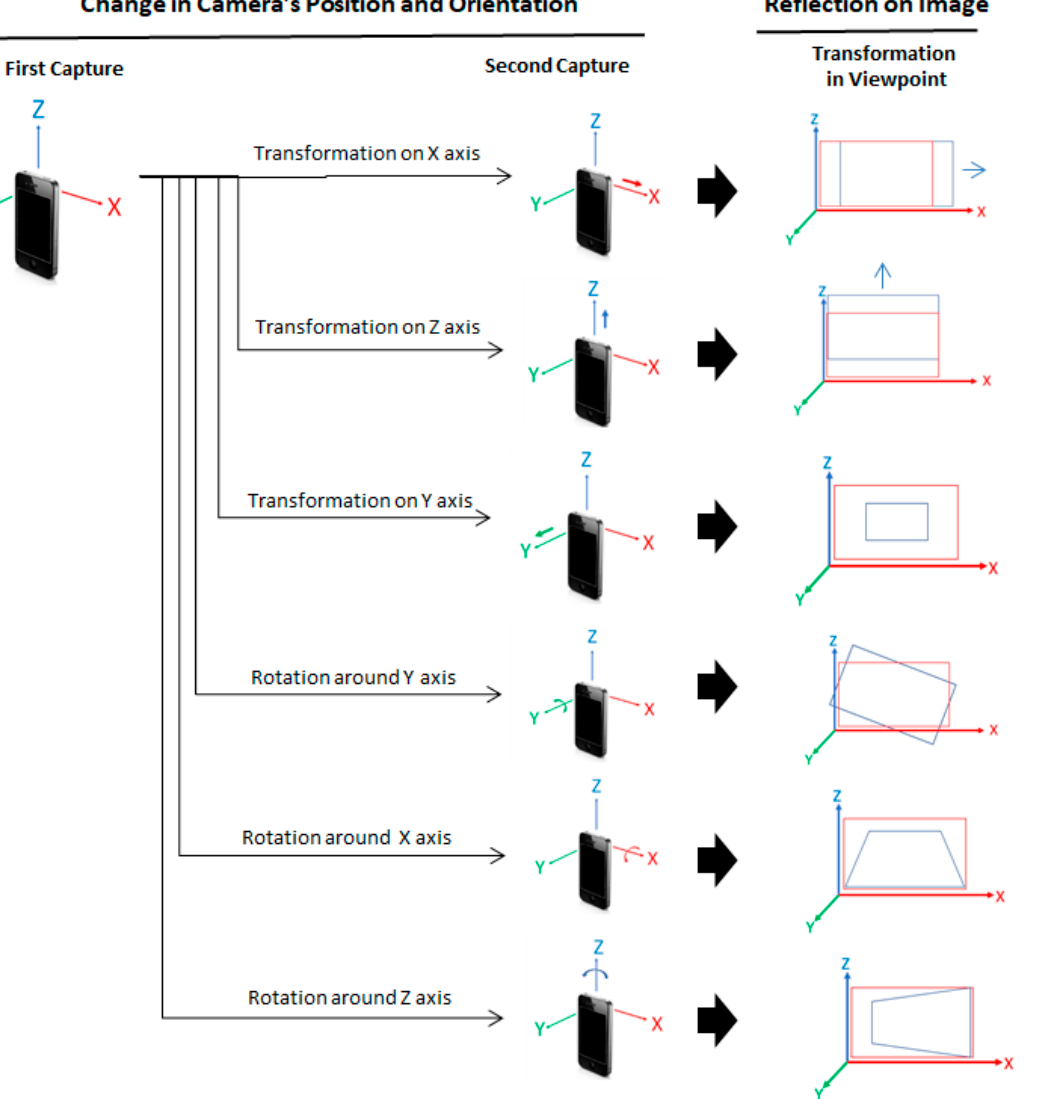
Figure 7. Changes in the camera’s position and orientation can cause image transformation.